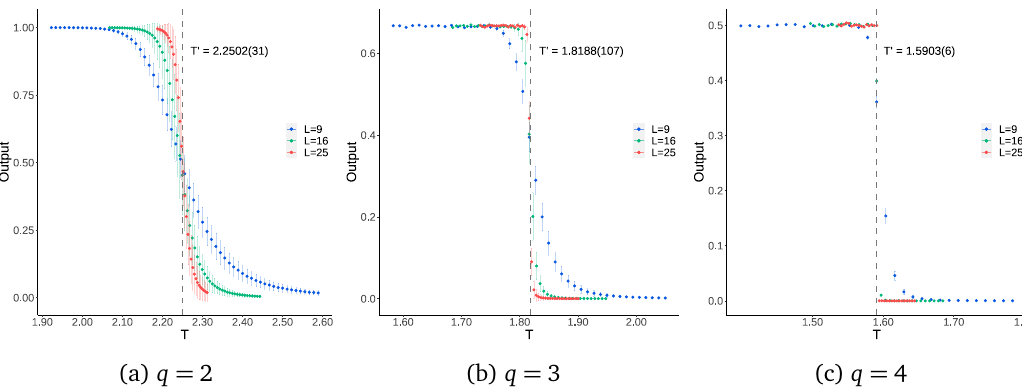
Figure 16: The relationship between temperature and the average output of an en- semble of 10 independently trained ANNs – training with simplified data, and testing with MC data of the ferromagnetic q -state Potts model on a cubic lattice. The error bars shown are 99.7% confidence intervals of the ensemble average.